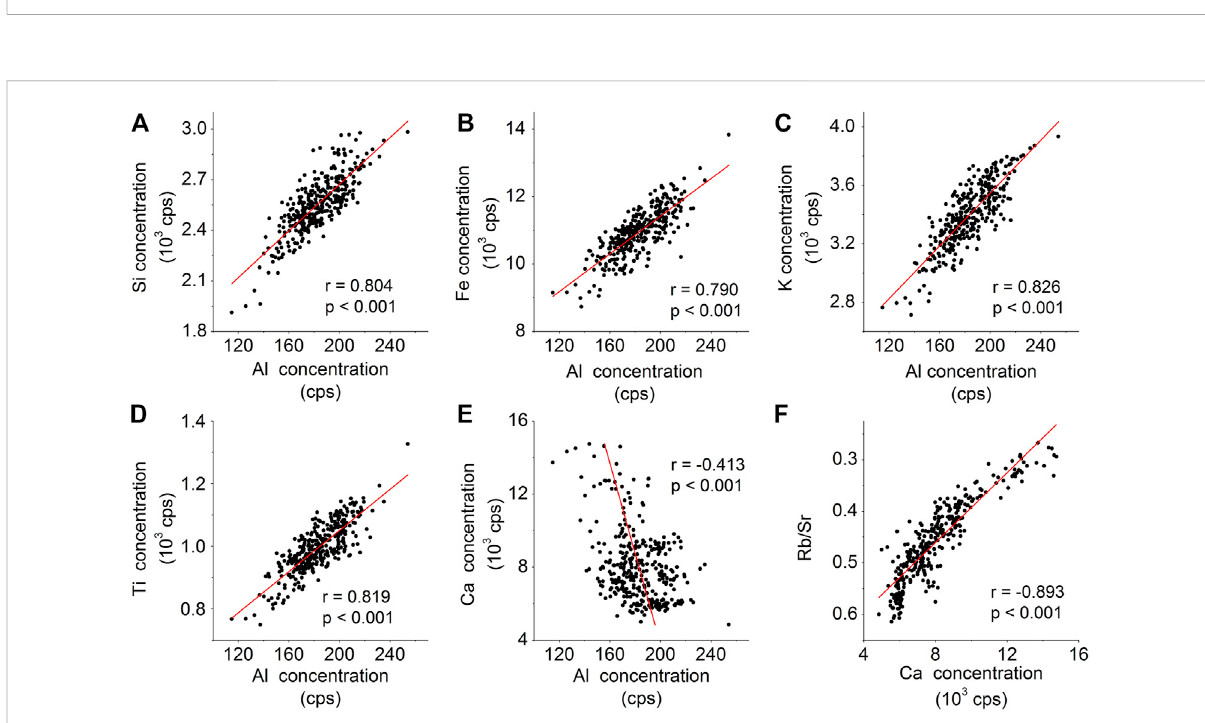
FIGURE 8 The Pearson correlation coef fi cient r and signi fi cance level p -value between Al concentrations and (A) Si, (B) Fe, (C) K, (D) Ti, (E) Ca concentrations, and (F) Ca concentration and Rb/Sr ratios. Age span of the above covers the last 1000 years.